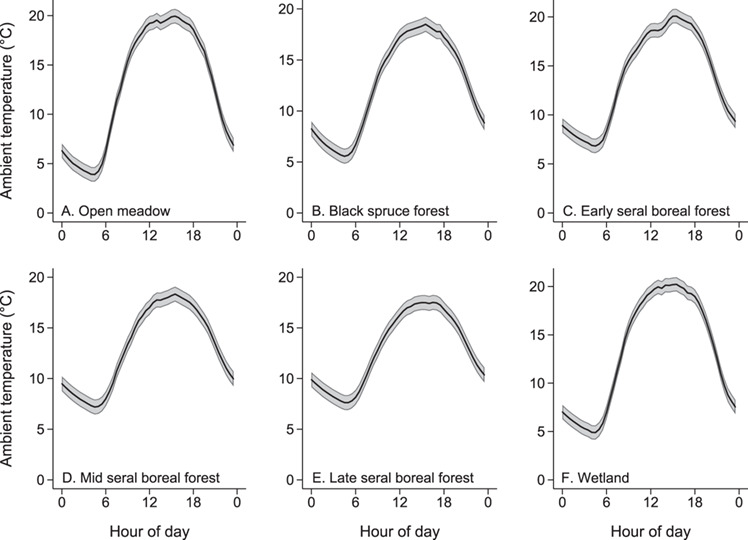
Patterns of daily ambient air temperature (°C) in six different habitat types (n = 30) during May through August 2015 at the Kenai Moose Research Center, Kenai Peninsula, Alaska, USA. Predicted values with 95% confidence intervals from mixed-effect model regression against time of day (0.5 h time periods starting at 0:00).